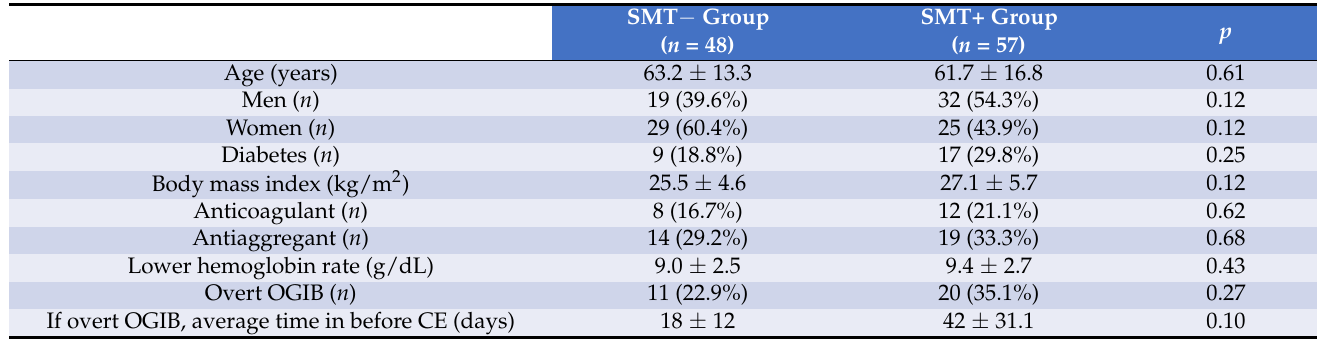
Figure 1. Study flow chart. SMT − stands for “without simethicone” whereas SMT+ means “with simethicone”. CE: capsule endoscopy; OGIB: obscure gastrointestinal bleeding; SB: small bowel. There were 51 male and 53 female patients in the study population, with a mean age of 62.4 ± 15.3 years. SB CE was indicated for overt OGIB in 31 patients (29.5%). Antiaggregant and anticoagulant treatments were used in 33 (31.4%) and 20 (19.0%) patients, respectively. There were no statistically significant differences in demographics and in clinical data between the two study groups (Table 2). Table 2. Clinical data. SMT– stands for “without simethicone” whereas SMT+ means “with sime- thicone”. OGIB: obscure gastro-intestinal bleeding; CE: capsule endoscopy.